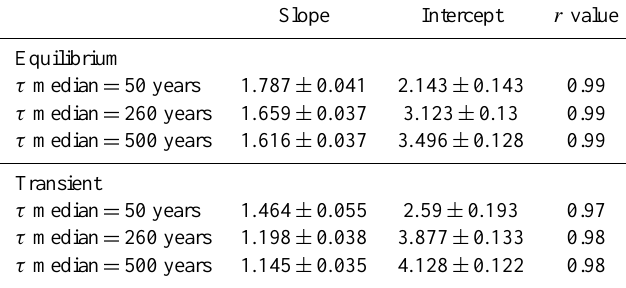
Table 4. Summary of regression results of the sensitivity analysis on floodplain sediment storage scaling. Here we consider only the previ- ously mentioned selected grid cells in the Rhine catchment area. τ is the residence time of floodplain sediment. The r value is the Pearson correlation coefficient, and the slope and intercept are the scaling